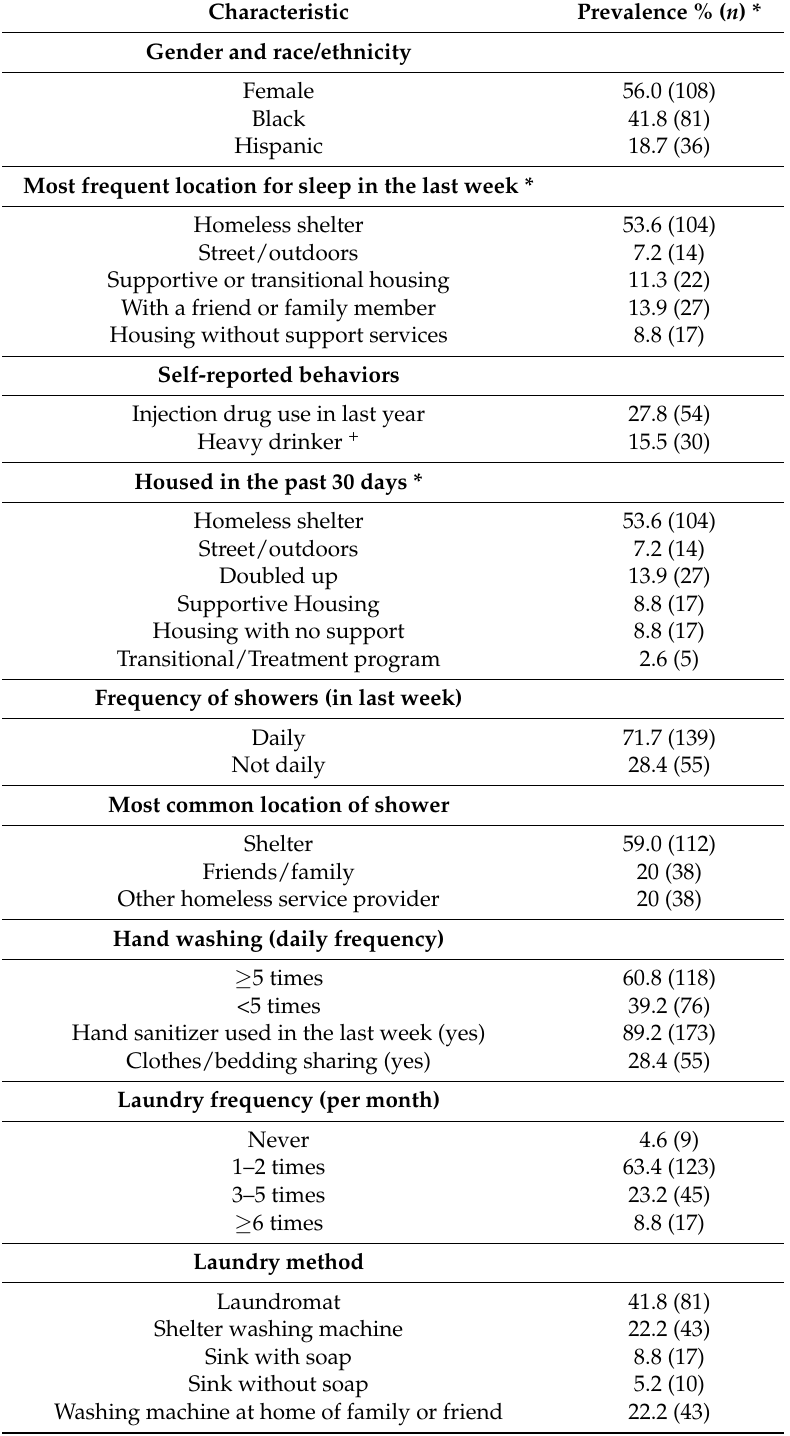
Table 1. Select demographics of study participants ( n =